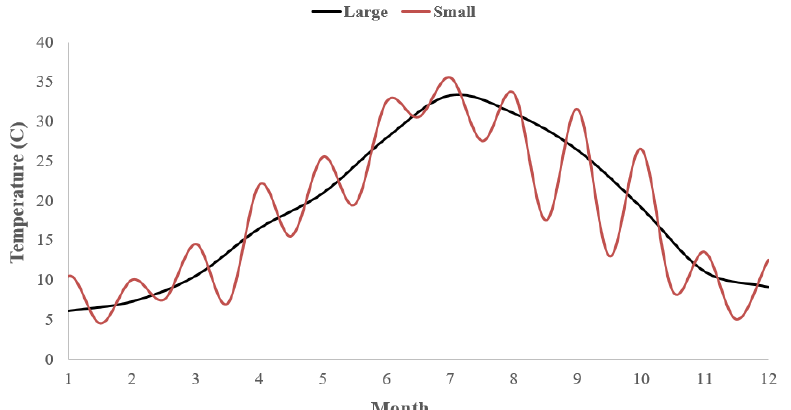
Figure 7. Comparison of temperature loading conditions in two different modes, including large and small variations.